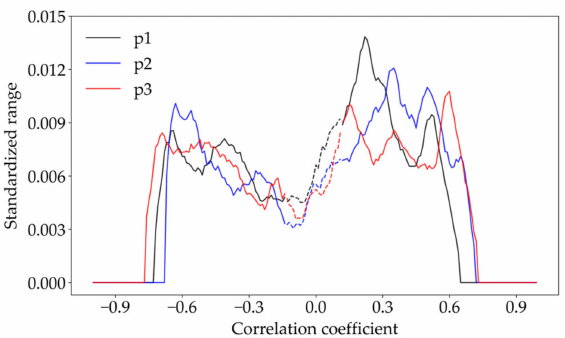
Figure 7. The standardized range corresponding to every 0.01 correlation intensity in the main coupling region between Niño-3.4 index series and SLP anomaly field (black dashed box in Figure 6). The standardized results are smoothed by nine equal weights. The p1, p2, and p3 are the same as in Figure 1. Solid (dashed) lines indicate passing (failing) the Student t -test with a confidence level of